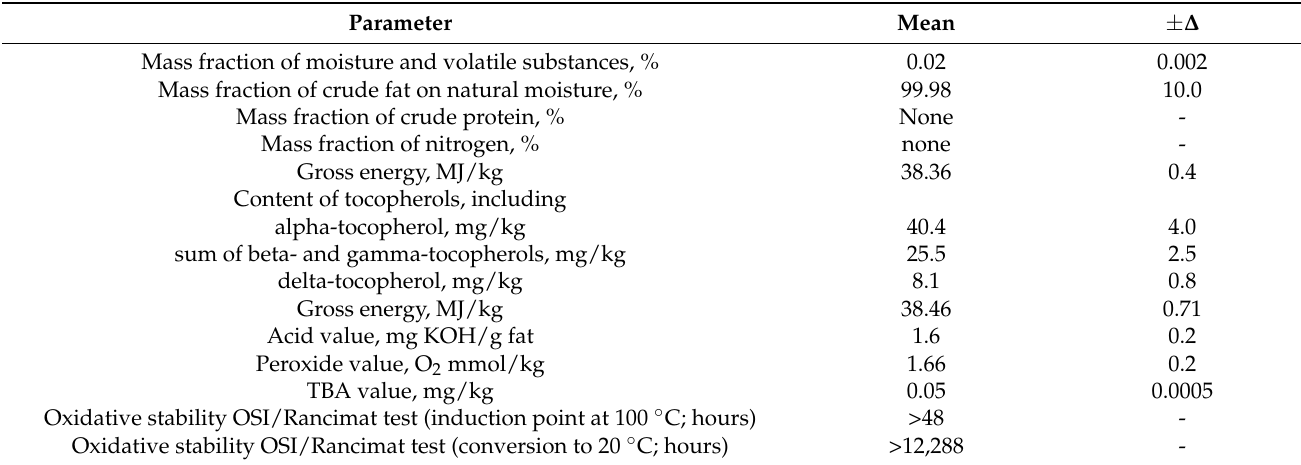
Table 2. Composition and properties of the fat of black soldier fly larvae.